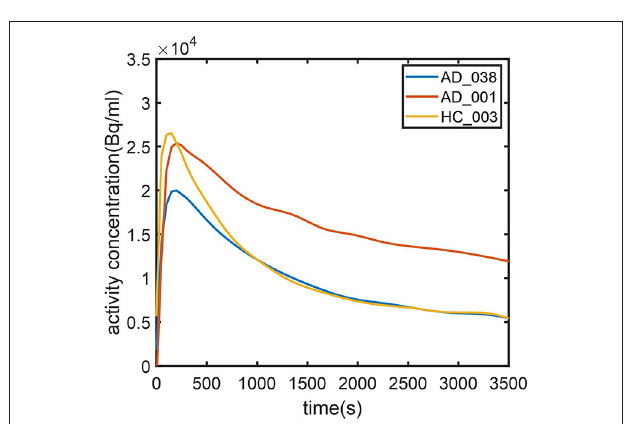
All of these associations between measures and clinical scores attained statistical significance with p < 0.01. AQI did not have a significantly higher correlation with the clinical scores than SUVR/ DVR